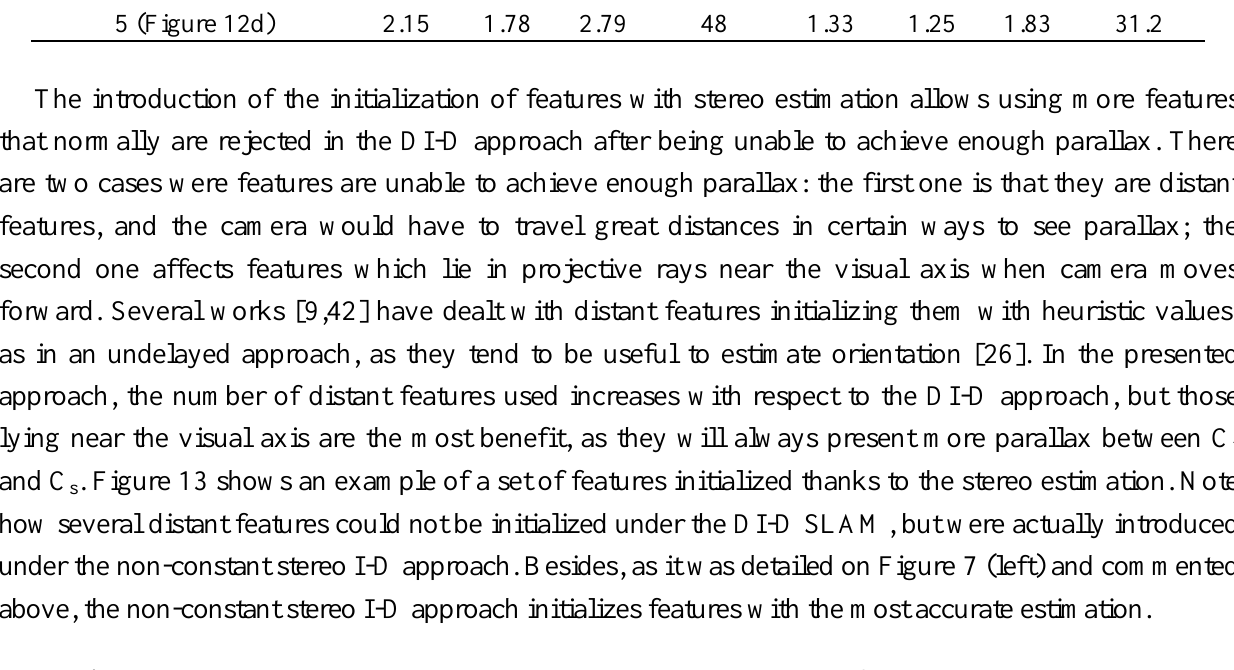
Figure 13. Landmarks initialized through stereo estimation. Left image: DI-D approach. Right top image: non-constant stereo I-D feature initialization. Right bottom image: image pair from C f